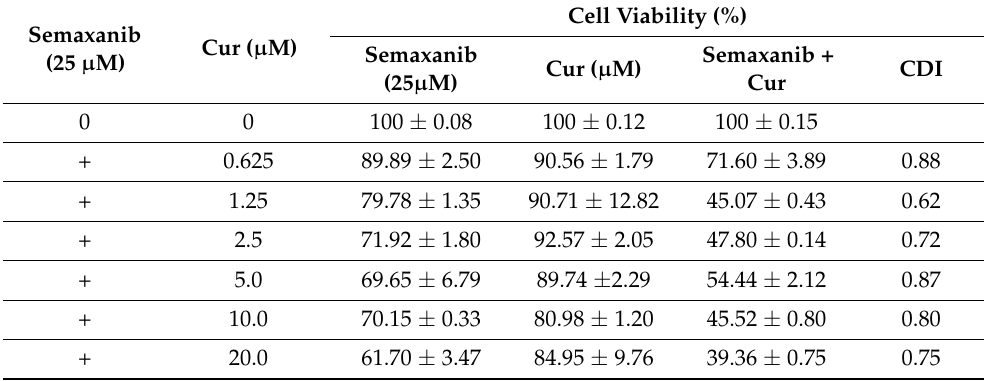
Table 3. Curcumin and semaxanib show synergistic effects on HUVECs’ cell viability.